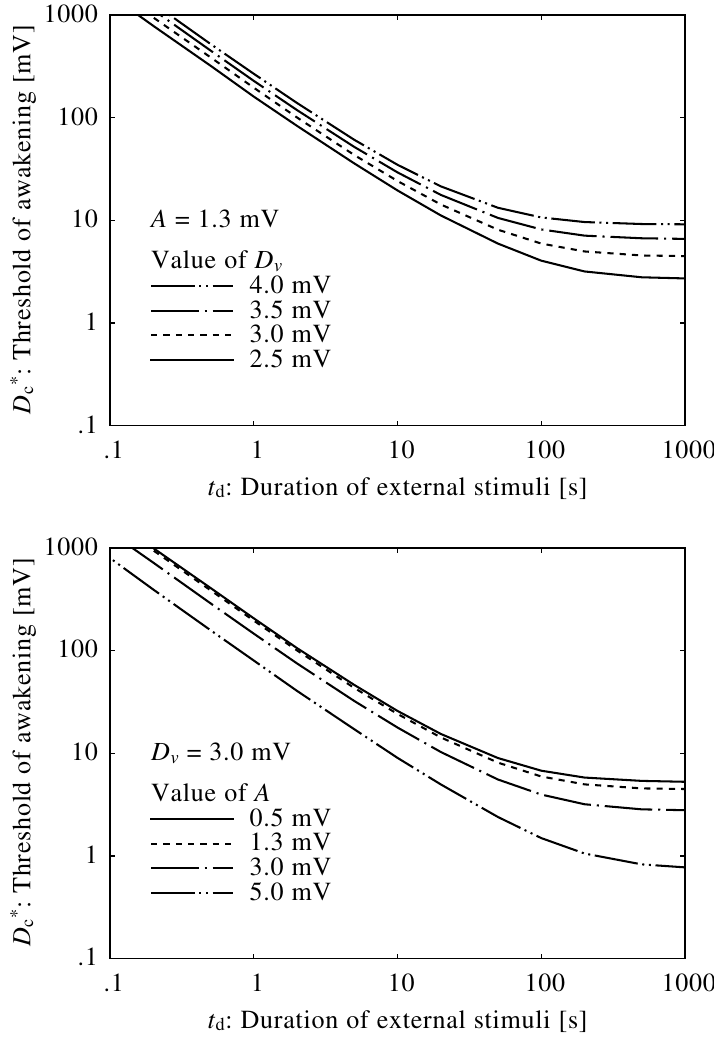
Figure 4. Relationship between neuroelectrical thresholds of awakening in response to external stimuli and varied duration of external stimuli using different values of D v and A